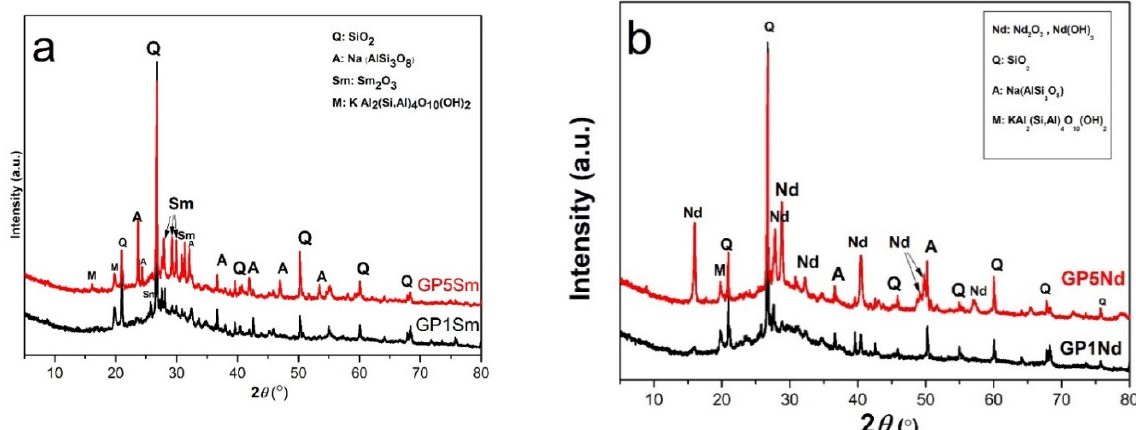
Figure 3. XRPD diffractograms of samples: ( a ) GP1Sm and GP5Sm and ( b ) GP 1Nd and GP5Nd. It is also evident, by comparing the diffractograms, that the peaks are slightly shifted to the left, which indicates the incorporation of Sm into the primary geopolymer